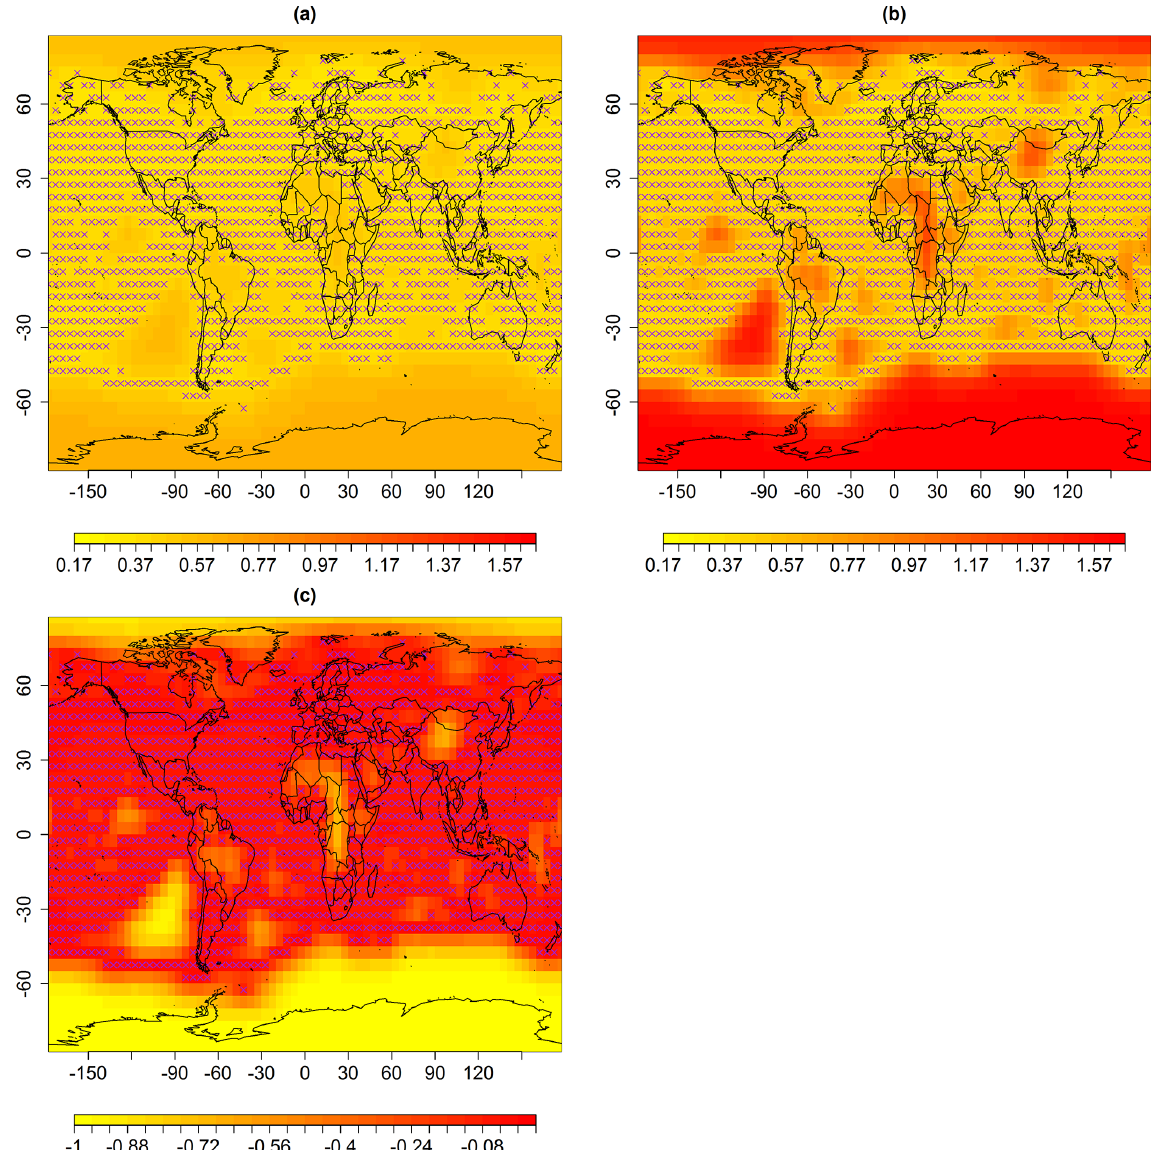
Figure B2. Standard error (uncertainties) in degrees Celsius associated with spatial predictions for the median in February 1932, using multi- resolution lattice kriging based on (a) ABC, using a variogram (Sect. 2.1), and (b) the profile maximum likelihood approach (Nychka et al., 2015) used to create data in Ilyas et al. (2017). (c) The difference in panels (a) and (b) , i.e., (a) – (b) . The × signs show observed spatial sites